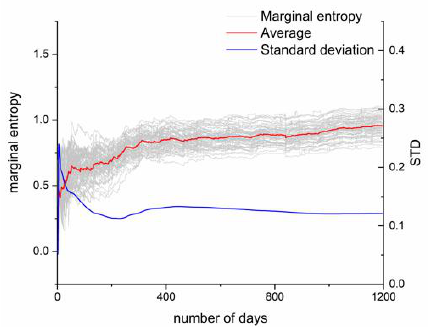
Figure 5. Time statistics of marginal entropy.